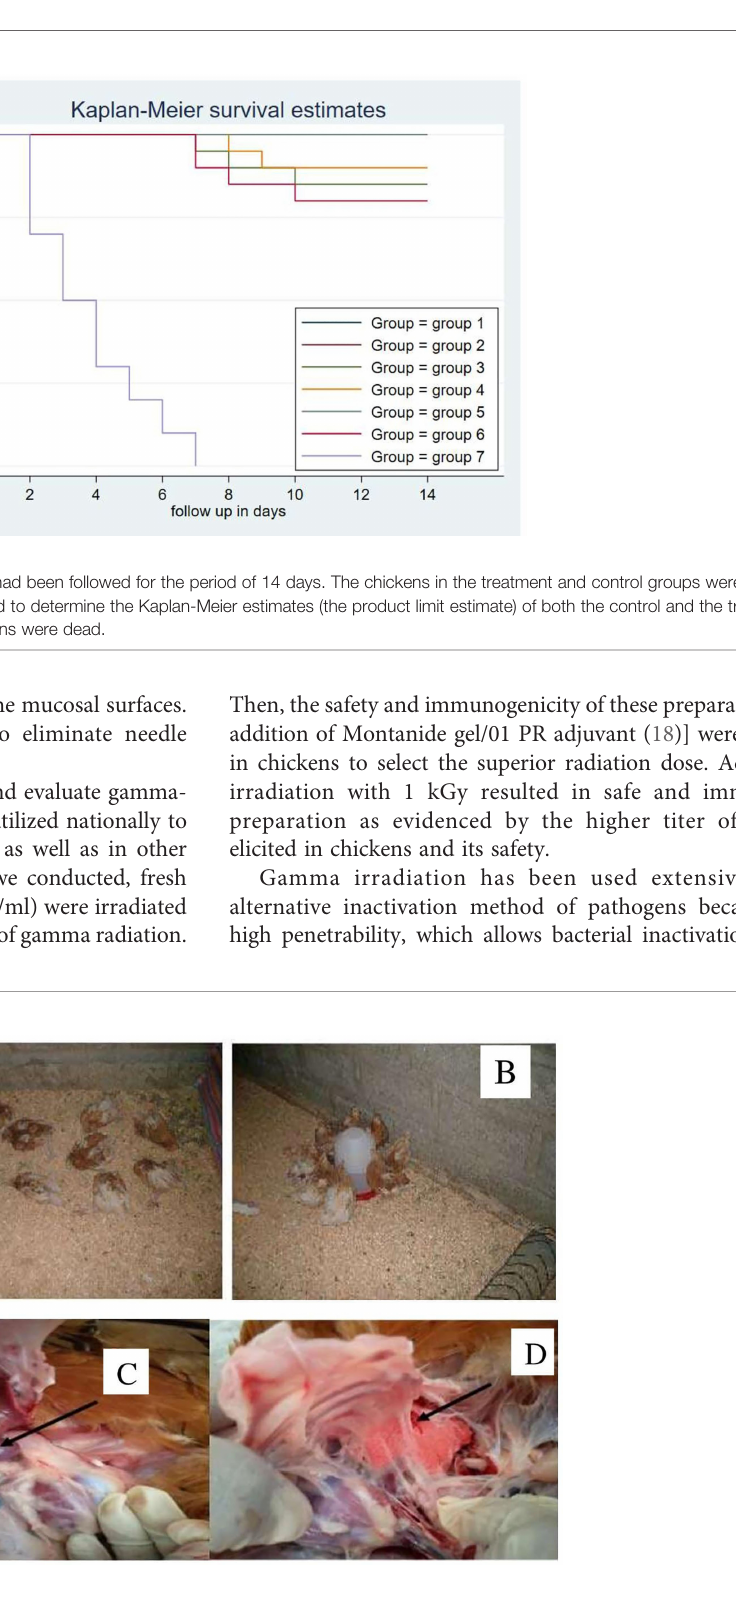
FIGURE 7 | The picture from (A – D) indicated the chickens died after challenge with P. multocida biotype A at day 56 and the postmortem result. (A, B) indicated the dead chickens within 2 weeks. (C, D) indicated splenomegaly and petechial and congested